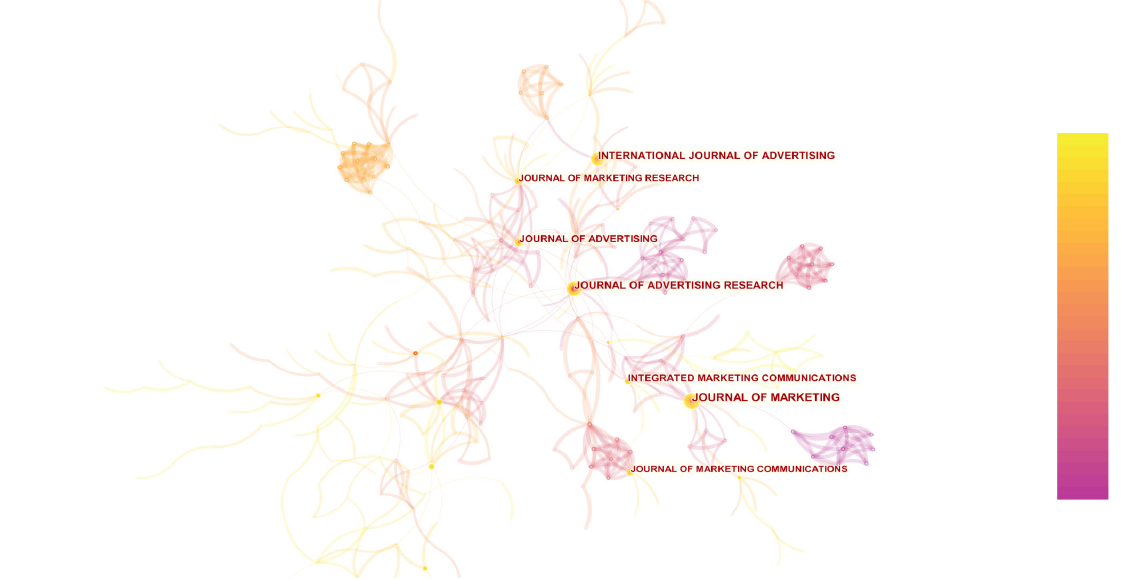
Figure 4. Co-occurrence map of journal